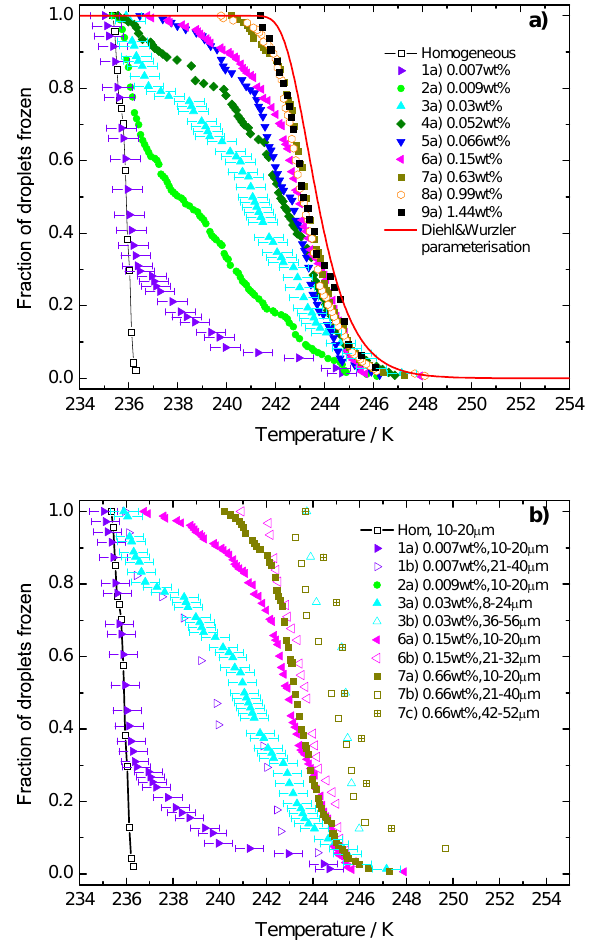
Fig. 3. (a) Fraction of droplets frozen in the 10–20µm size bin as a function of temperature for water droplets containing known con- centrations of illite cooled at 5Kmin − 1 . We also show the droplet volume dependent parameterisation of Diehl and Wurzler (2004) for 15µm droplets which is based on the data of Hoffer (1961). (b) Comparison of the fraction of droplets frozen in different size bins as a function of temperature (cooling rate 5Kmin − 1 ) .